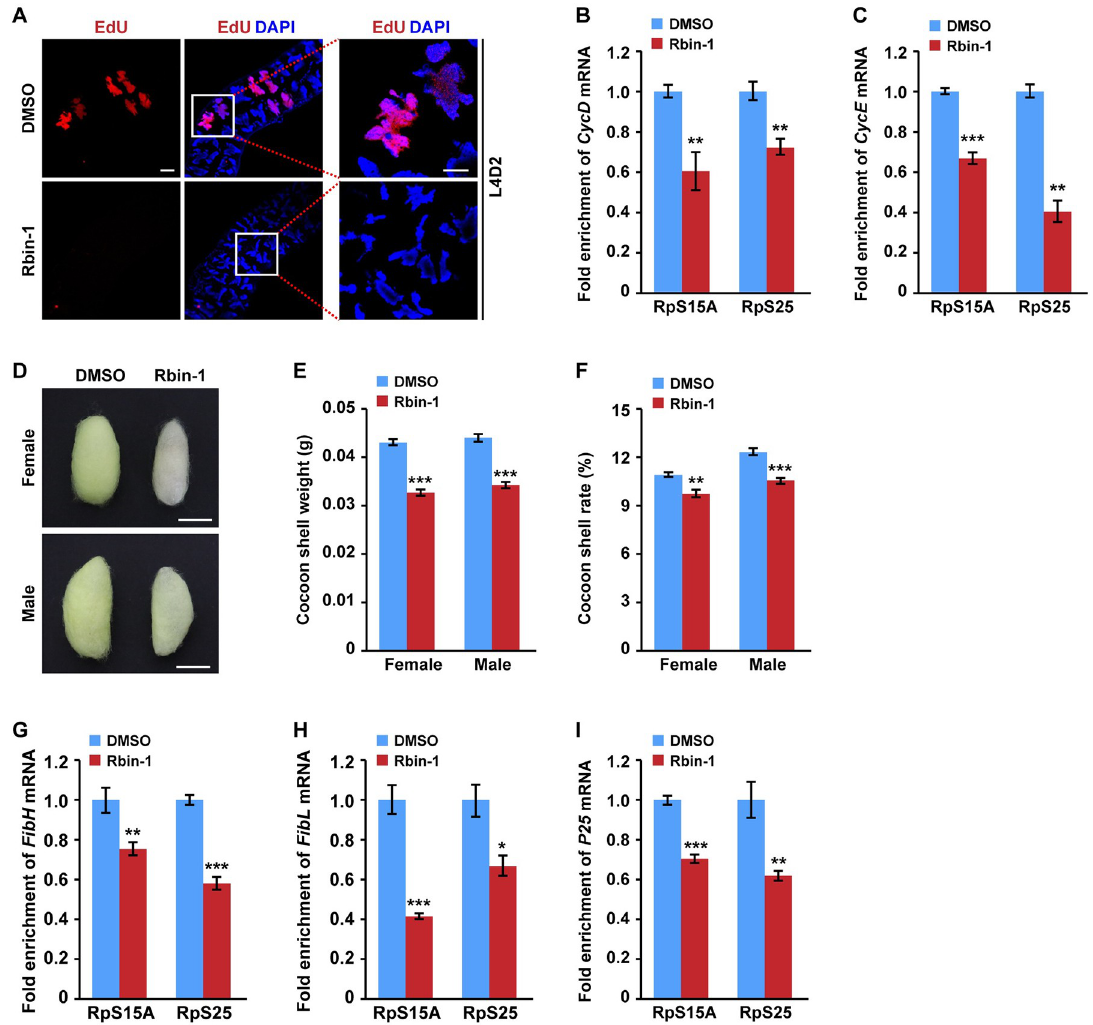
Fig 6. The treatment with the ribosome biogenesis pathway inhibitor Rbin-1 inhibits endoreplication and silk production. ( A ) EdU staining in silkworm PSG cells following treatment with Rbin-1 as an inhibitor of ribosome biogenesis. DMSO treatment was used as a control. The PSG cells of the control could be strongly stained with EdU, but no EdU signal was detected in PSG cells with Rbin-1 treatment. Scale bar, 100 μ m. ( B-C ) Rbin-1 treatment decreased the translation level of CycD (B) and CycE (C). The anti-RpS15A and anti-RpS25 antibodies were used. ( D ) Changes in cocoon size of female and male silkworm larvae following Rbin-1 treatment. Scale bar, 1 cm. ( E-F ) Rbin-1 treatment decreased the cocoon shell weight (E) and cocoon shell rates (F). ( G-I ) Rbin-1 treatment decreased the translation level of FibH (G), FibL (H), and P25 (I). Values were represented as means ± S.E. (error bars). For the significance test: � P < 0.05, �� P < 0.01, and ��� P < 0.001 versus the